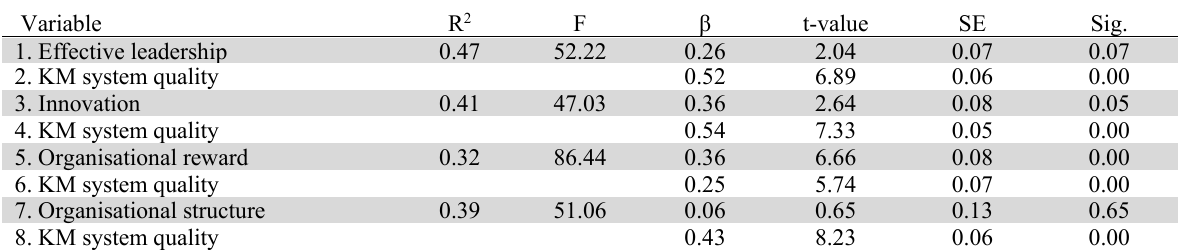
Multiple regression